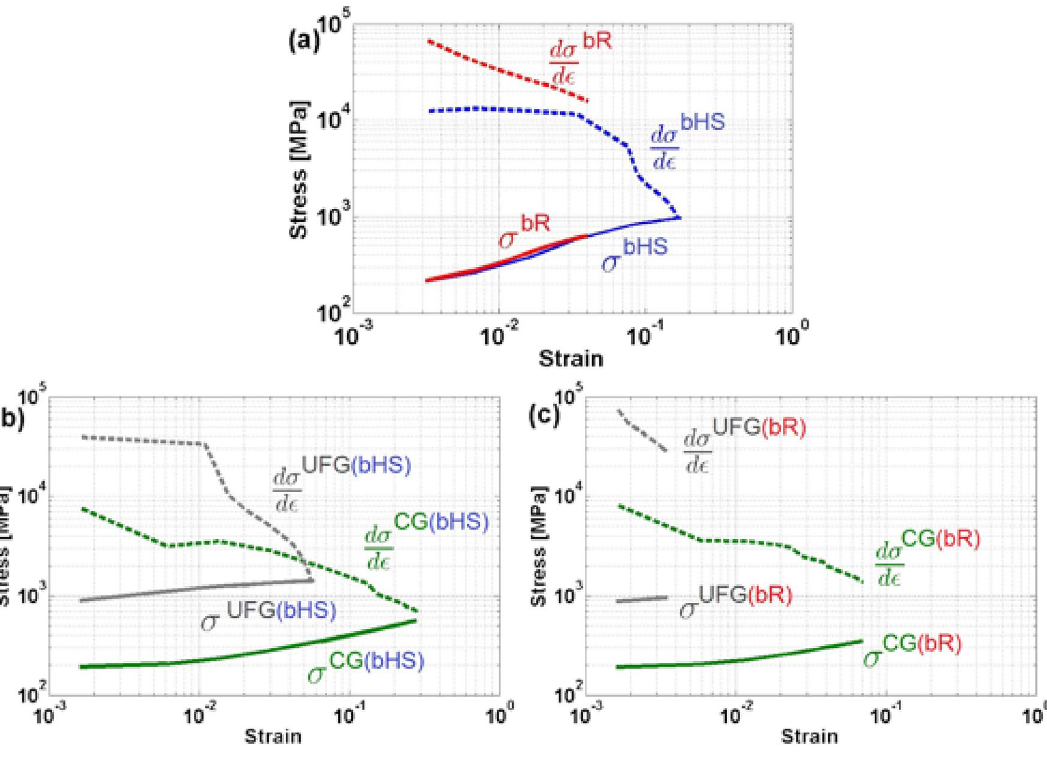
Figure 7. Mean true stress σ eff (solid lines) and strain hardening rate ∂σ/∂ε (dash lines) versus true strain ε eff curves in log–log scale for the simulated ( a ) entire volumes of bHS and bR material materials, and separately for each CG and UFG phase in ( b ) bHS and ( c ) bR materials.